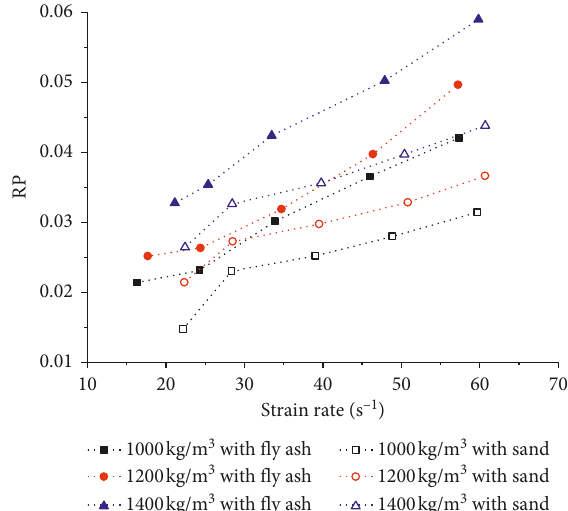
Figure 18: Relationship between the tenacity (RP) and the strain rate.